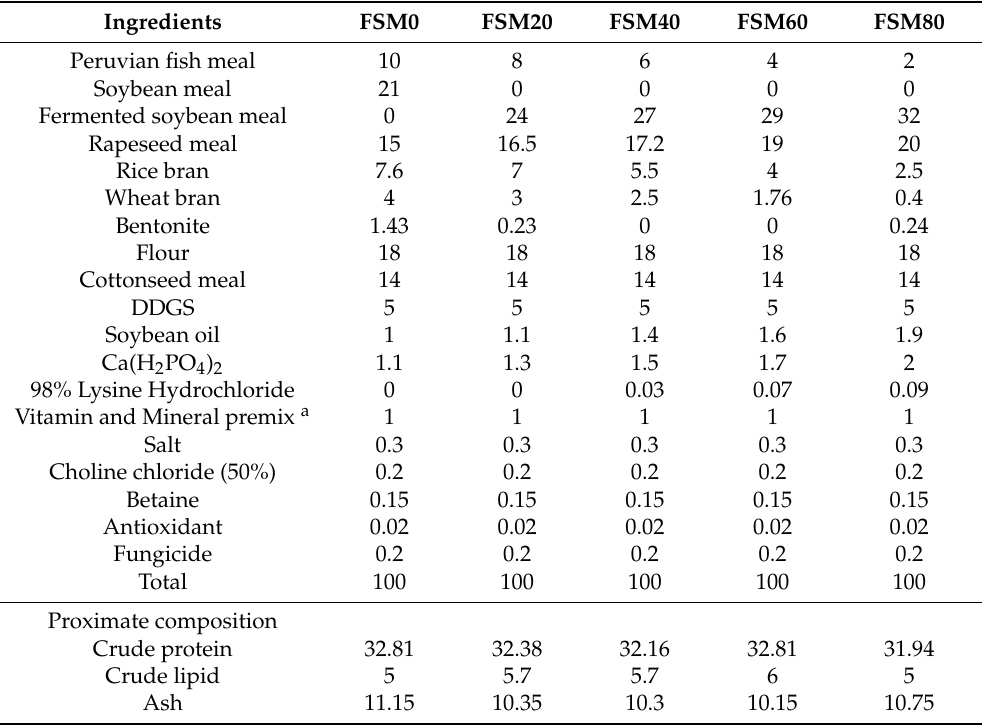
Table 1. Ingredients and proximate composition of experimental diets (% dry-matter basis).